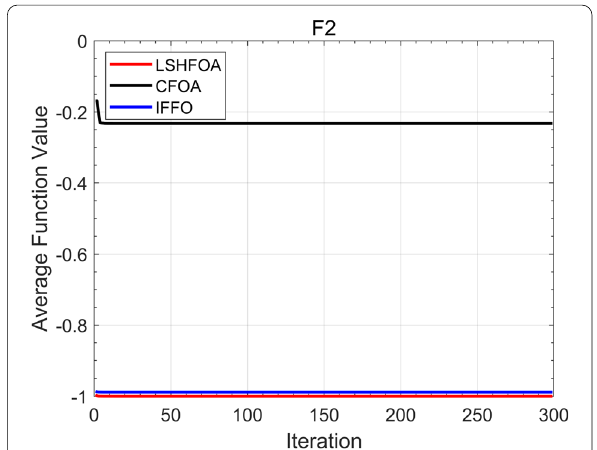
Fig. 10 Performance of the algorithm under F4 function